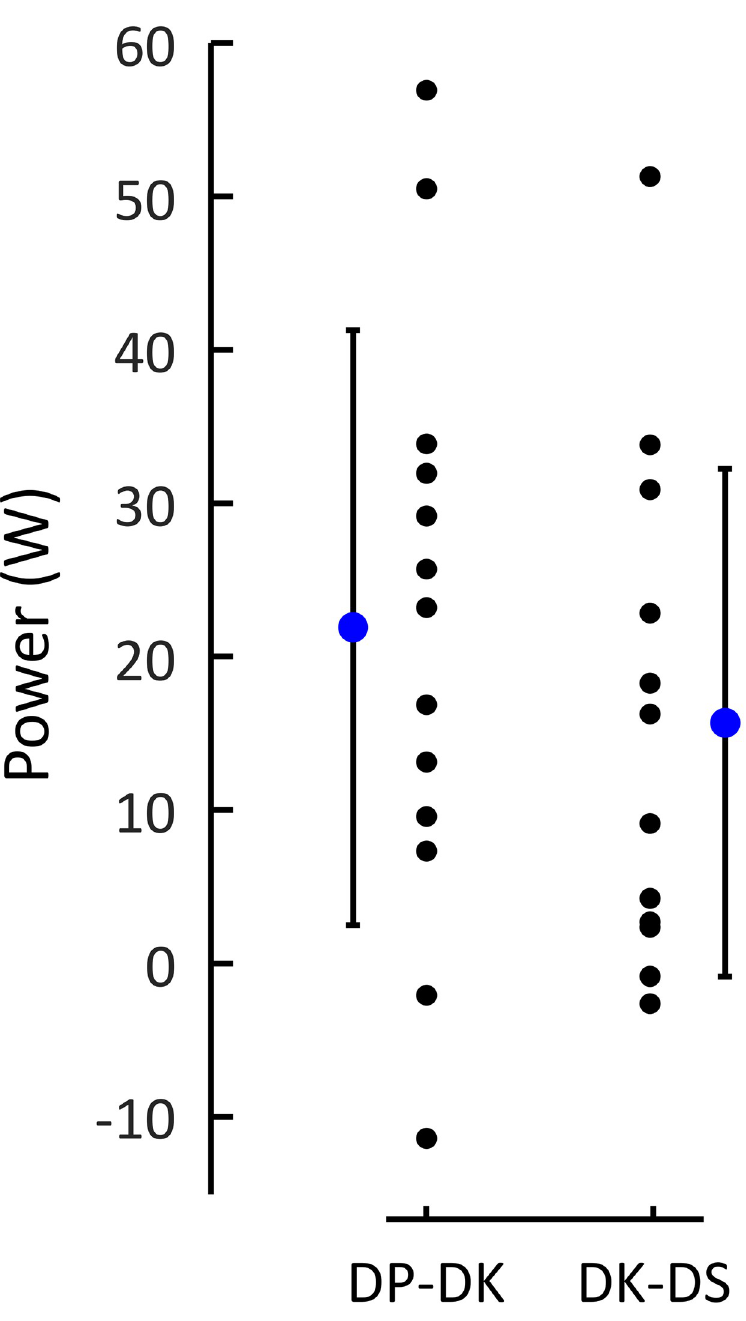
Fig 5. Mean, SD and individual values of mechanical power difference for technique transitions when increasing and decreasing resistive force. The data are the means over the four protocol sessions per athlete.